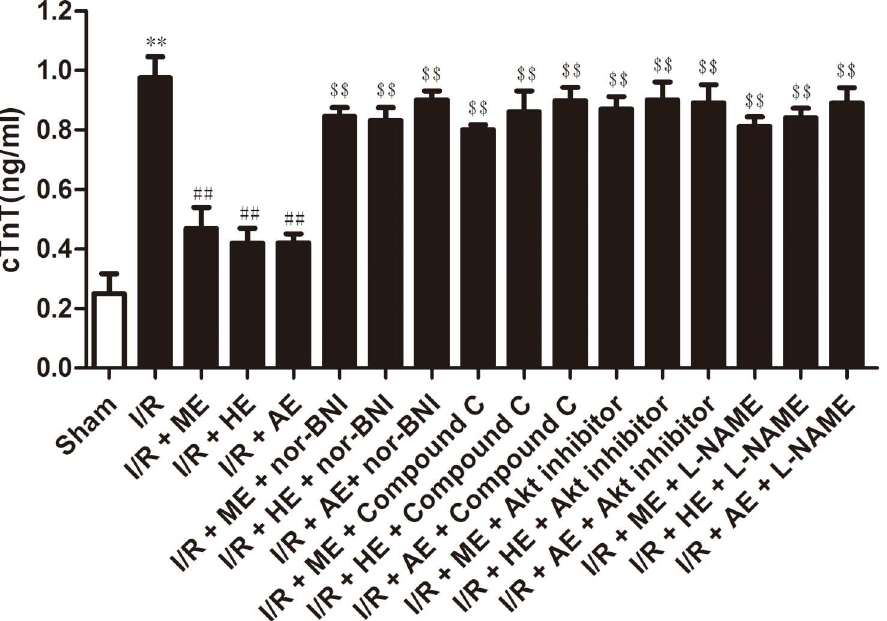
Fig 3. Effects of exercisetraining on cTnT in serum after I/R. All results are expressedas the means ± SEM.I/R, 30 min ischemiaand 120 min reperfusion;I/R + ME, moderate intensity exercise for 8 wk before I/R; I/R + HE, high intensity exercise for 8 wk before I/R; I/R + AE, acute exercise before I/R; I/R + ME+ nor-BNI, moderate intensity exercise for 8 wk before I/R plus nor-BNI (2.0 mg/kg); I/R + HE + nor-BNI, high intensity exercise for 8 wk before I/R plus nor-BNI (2.0 mg/kg); I/R + AE + nor-BNI; acute exercise before I/R plus nor- BNI (2.0 mg/kg); I/R + ME + Compound C, moderate intensity exercise for 8 wk before I/R plus CompoundC (20 mg/kg); I/R + HE + CompoundC, high intensity exercise for 8 wk before I/R plus CompoundC (20 mg/kg); I/R + AE + CompoundC, acute exercise before I/R plus CompoundC (20 mg/kg); I/R + ME + Akt inhibitor, moderate intensity exercise for 8 wk before I/R plus Akt inhibitor (0.3 mg/kg); I/R + HE + Akt inhibitor,high intensity exercise for 8 wk before I/R plus Akt inhibitor(0.3 mg/kg); I/R + AE + Akt inhibitor,acute exercise before I/R plus Akt inhibitor(0.3 mg/kg); I/R + ME + L-NAME, moderate intensity exercise for 8 wk before I/R plus L-NAME (30 mg/kg); I/R + HE + L-NAME, high intensity exercise for 8 wk before I/R plus L-NAME (30 mg/kg); I/R + AE + L-NAME, acute exercise before I/R plus L-NAME (30 mg/kg). n = 8, ** P < 0.01vs. sham, ## P < 0.01vs. I/R, $$ P < 0.01vs. I/R+ME, I/R+HE, I/R+AE,